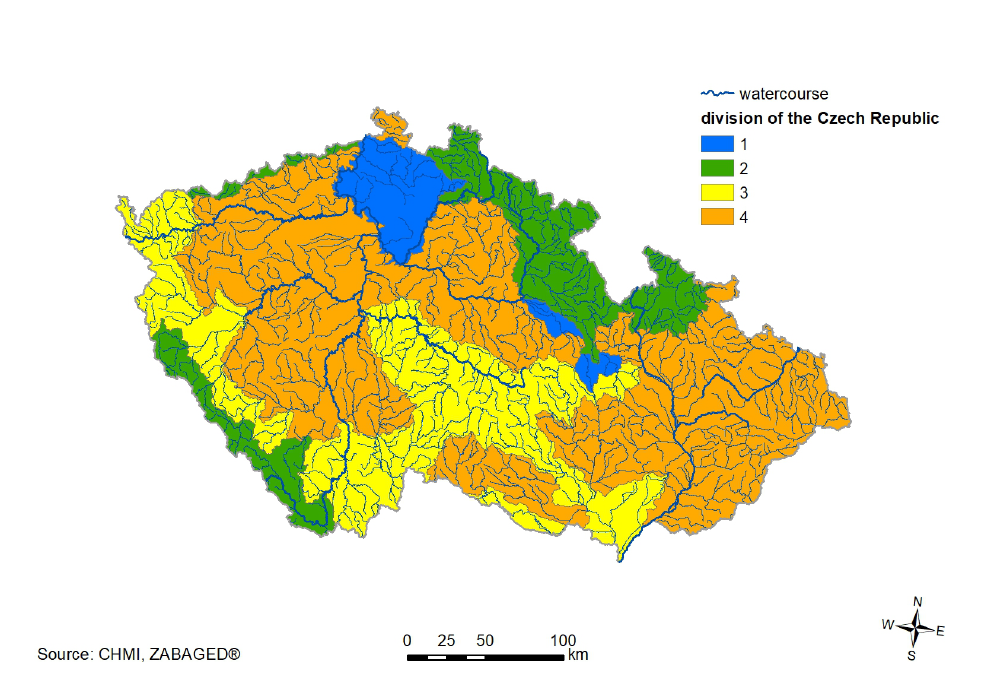
Figure 5. Spatial division of the Czech Republic into individual areas for different MRF calculation based on the coefficient K 99